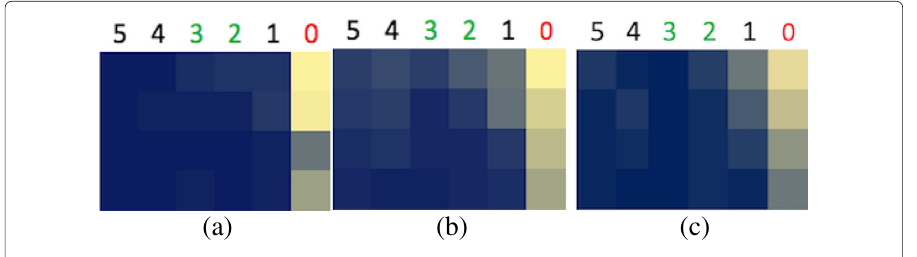
Fig. 4 Activity categorized by students’ performance. a Low, b Medium, c